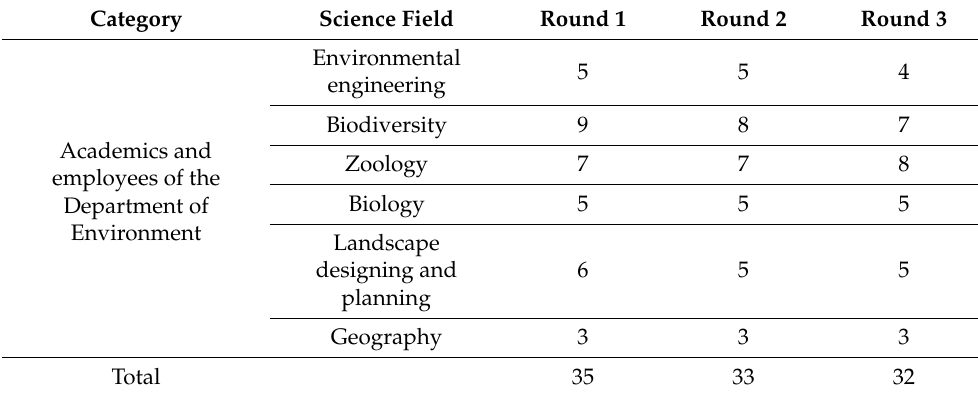
Table 3. Experts who participated in the Delphi